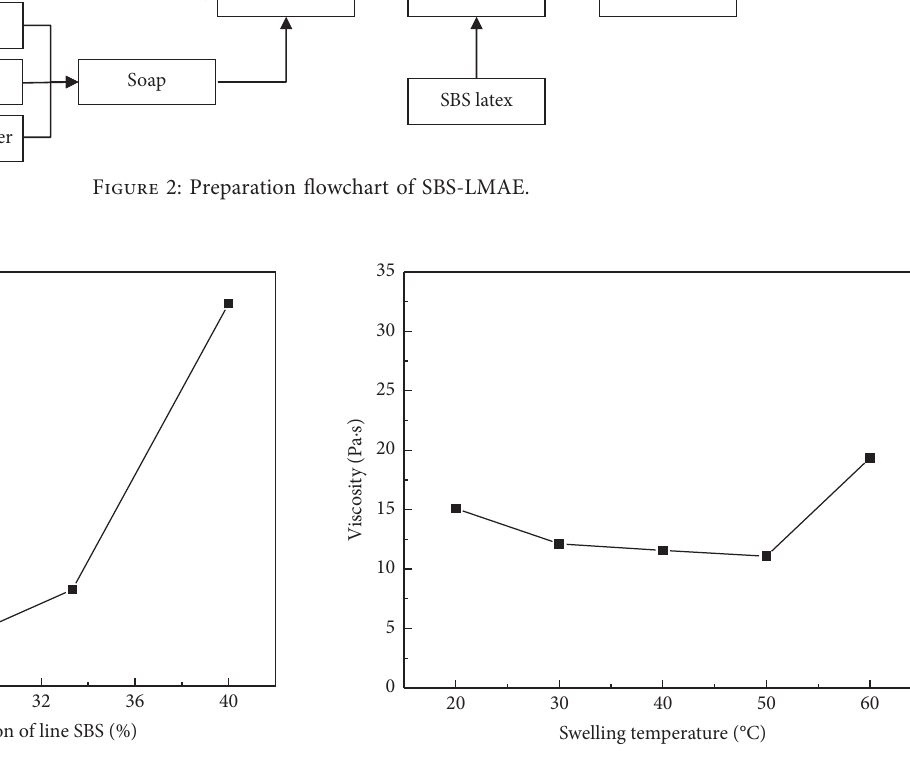
Figure 4: Influence of temperature on the viscosity of SBS solutions.